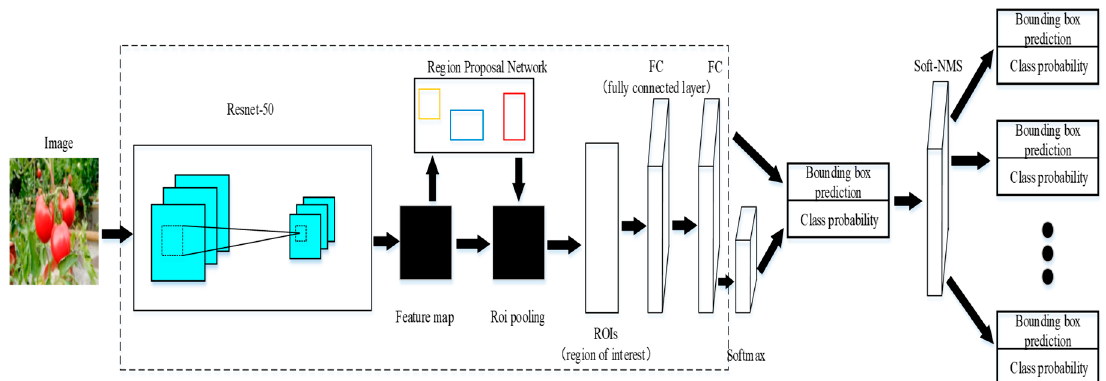
Figure 3. Improved framework for the Faster R-CNN model. Firstly, the image is input, and the characteristics of the key organs of tomato are extracted through the feature extraction network Resnet-50, to generate a feature map. Then, ROI pooling is performed after the region proposals are generated on the feature map. At last, the recognition and localization tasks are completed after two fully connected layers.